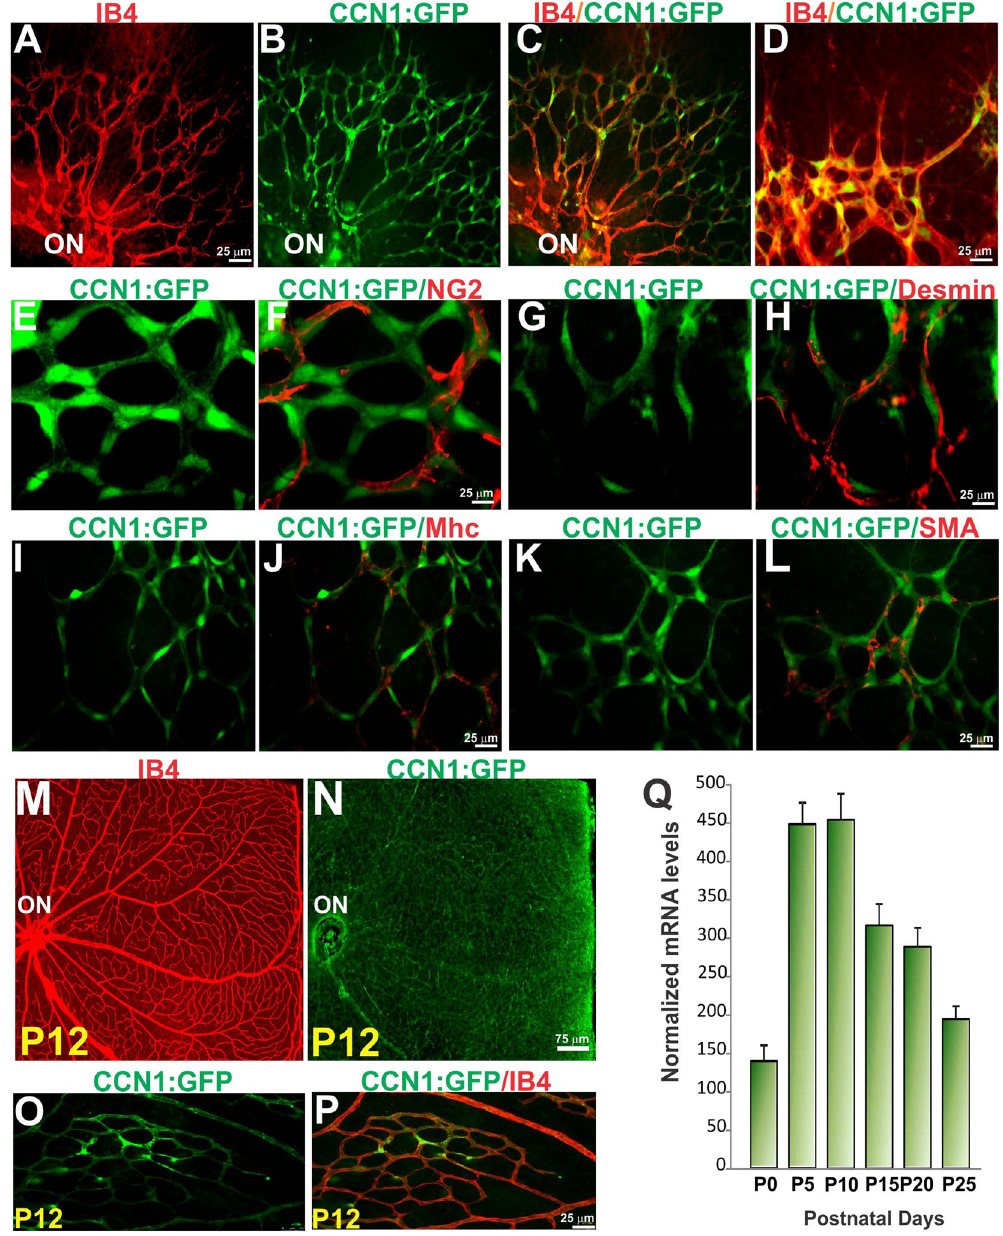
Figure 1. Expression of CCN1 during postnatal vascular development in the retina. ( A–D ) Flat-mounted preparations of retinas from transgenic mice expressing the GFP reporter gene under the control of the CCN1 promoter were analyzed for cellular localization of the CCN1:GFP signal in the growing vasculature. Images shown depict colocalization in P4 retinas of the CCN1:GFP signal with the endothelium-specific marker IB4. ( E–P ) The CCN1:GFP signal does not colocalize with mural cell markers including NG2, desmin, myosin heavy chain (mhc) and smooth muscle α -actin (SMA). Retinas with completely formed vasculature at P16 expressed residual amount of the CCN1:GFP in the vascular wall (ON: optic nerve). ( Q ) The transcript levels of the endogenous CCN1 gene during postnatal development of the retinal vasculature was determined by qPCR and normalized to 18S ribosomal RNA. (n =